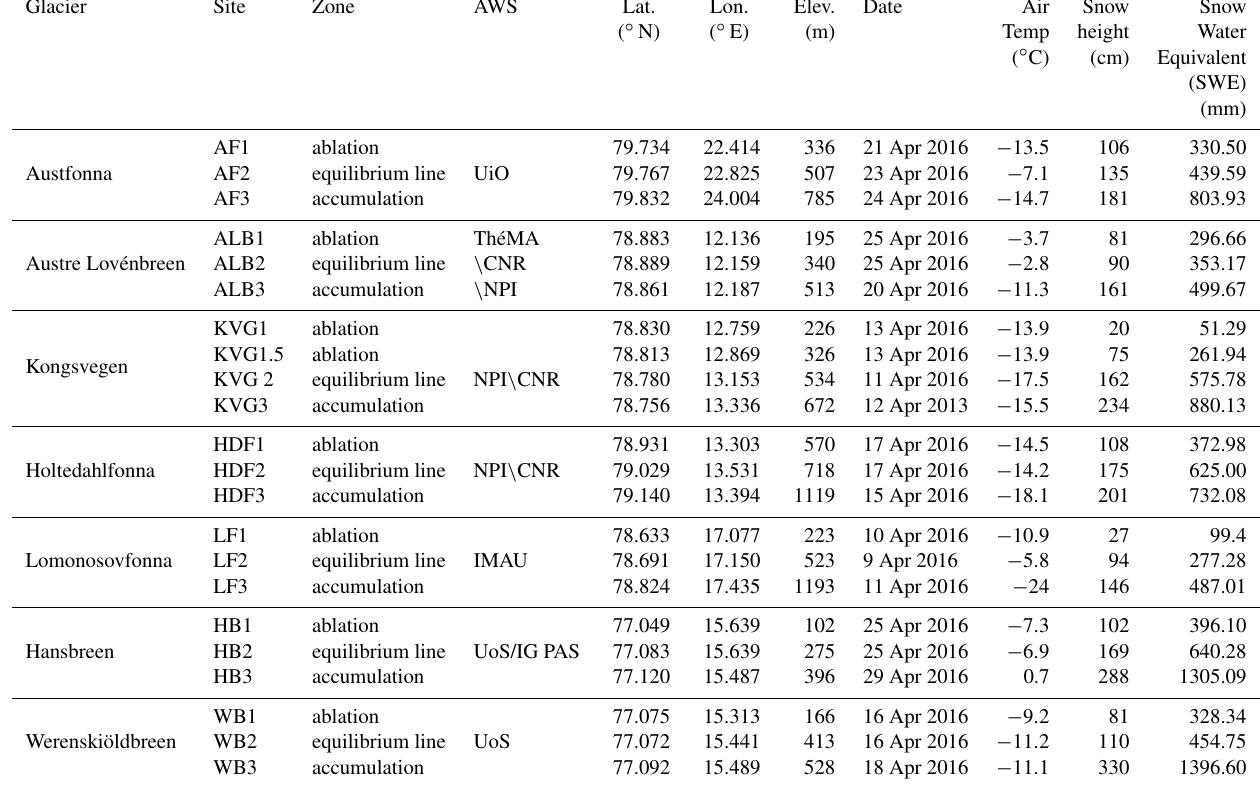
Table 1. Glaciers and sampling sites included in this study with their main characteristic. The air temperature was measured with a digital thermometer when the operators started to dig the snowpits. AWS: atmospheric weather station; UiO: University of Oslo; ThèMA: Thèoriser & Modèliser pour Amènager, University of Franche-Comté; NPI: Norwegian Polar Institute; IMAU: Institute for Marine and Atmospheric Research, Utrecht University; UoS: University of Silesia; IG PAS – Institute of Geophysics, Polish Academy of Sciences; CNR – Con- siglio Nazionale delle Ricerche. Seven glaciers were considered at three different altitudes: (1) lower ablation zone; (2) ELA; (3) upper accumulation zone. Exceptionally, two snowpits (KVG 1 and KVG 1.5) were dug in the ablation zone of Kongsvegen glacier.